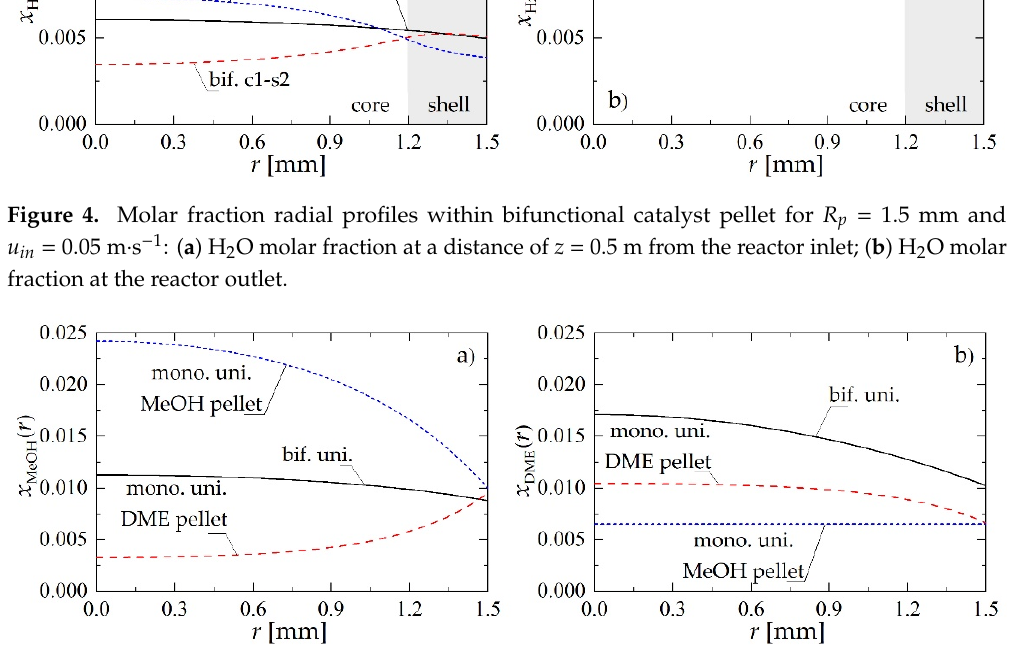
Figure 5. Molar fraction profiles within a bifunctional catalyst pellet with uniform distribution of catalytic sites, and monofunctional MeOH and DME catalyst pellets mixed uniformly in the reactor for R p = 1.5 mm and u in = 0.05 m·s −1 at a distance of z = 0.5 m: ( a ) MeOH molar fraction; ( b ) DME molar fraction.